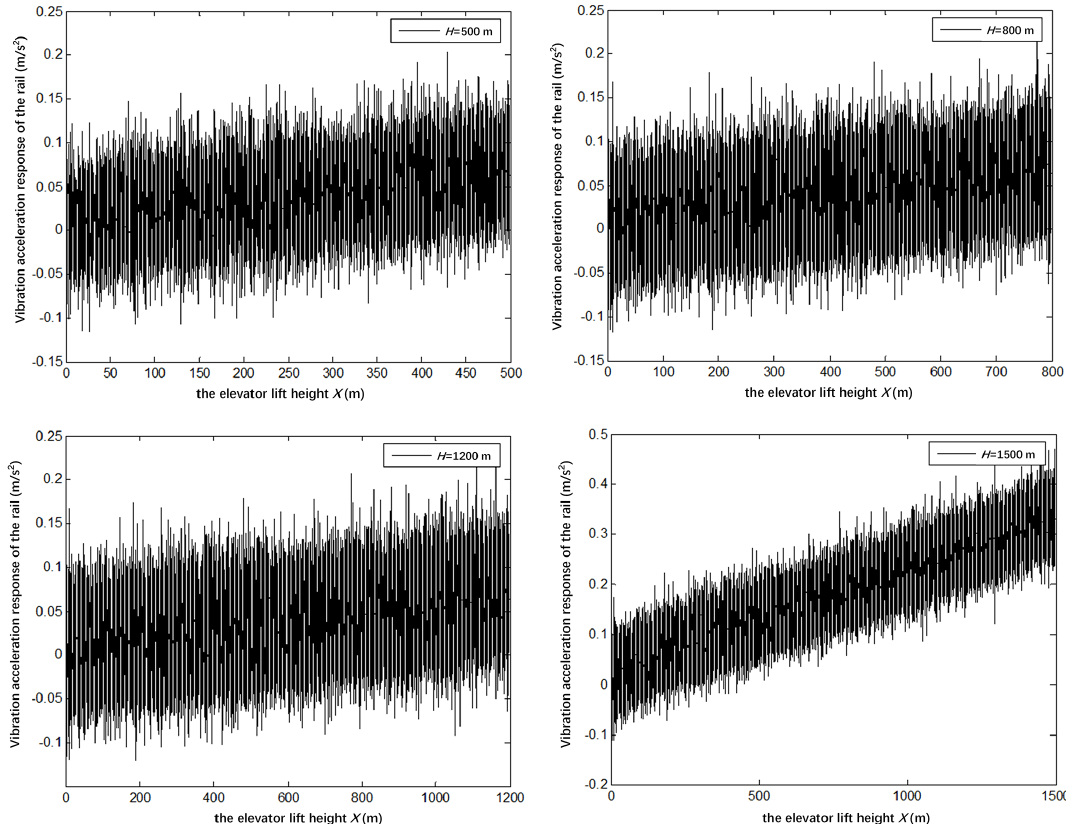
Figure 5. Vibration acceleration curve of the elevator guide rail under different building heights.